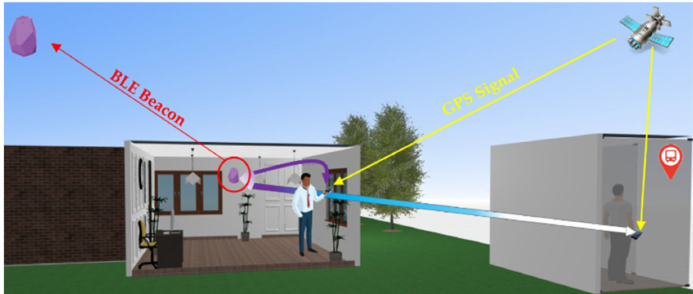
Figure A2. Representation of the difference between BLE and GNSS technology to consider phys- ical obstructions among; The gradient color schematically illustrates radio signal strength in BLE technology (i.e., purple and white colors represent the strongest and weakest radio signal strength).